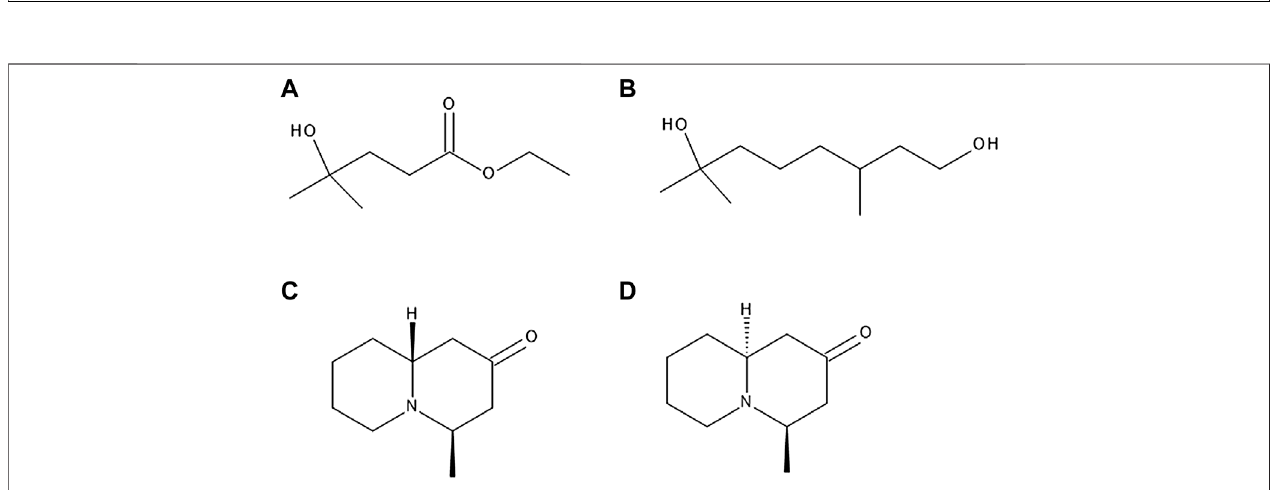
FIGURE 4 | The chemical structures of ethyl 3-hydroxy-3-methylbutanoate (A) , hydroxycitronellol (B) , myrtine (C) and epimyrtine (D) .